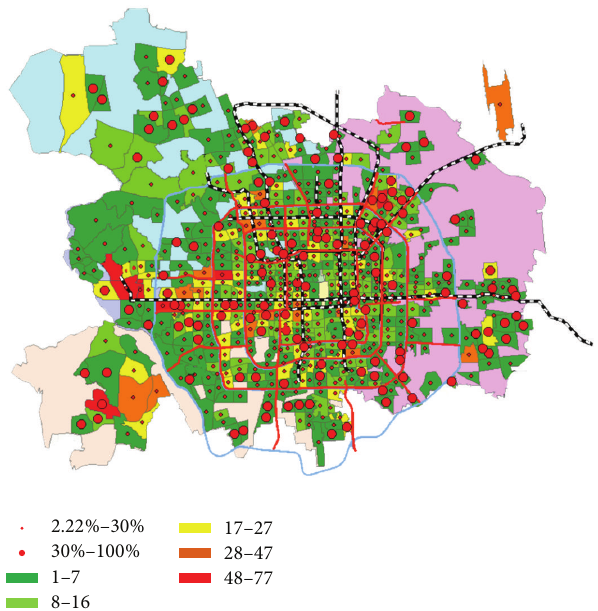
Figure 1: Number and proportion of short distance car trips in each TAZ.